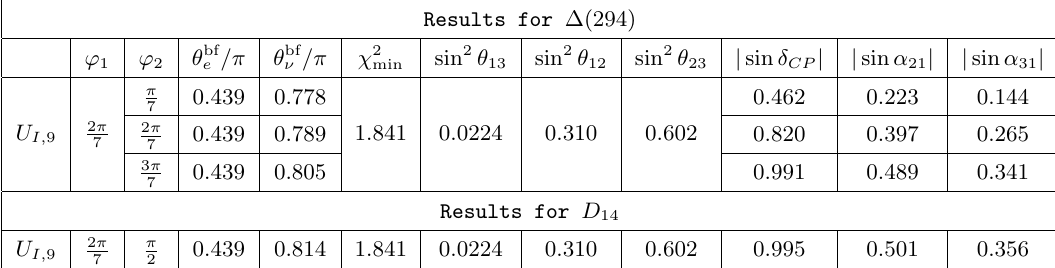
Table 4 . Results of the (cid:31) 2 analysis for the permutations of the mixing patterns U I obtained from the (cid:1)(294) and D 14 (cid:13)avor groups. Notice that only the mixing matrix U I; 9 can accommodate the experimental data. We display the values of sin 2 (cid:18) ij , j sin (cid:14) CP j , j sin (cid:11) 21 j and j sin (cid:11) 31 j at the best (cid:12)tting point ( (cid:18) e ; (cid:18) (cid:23) ) = ( (cid:18) bf ; (cid:18) bf e (cid:23)